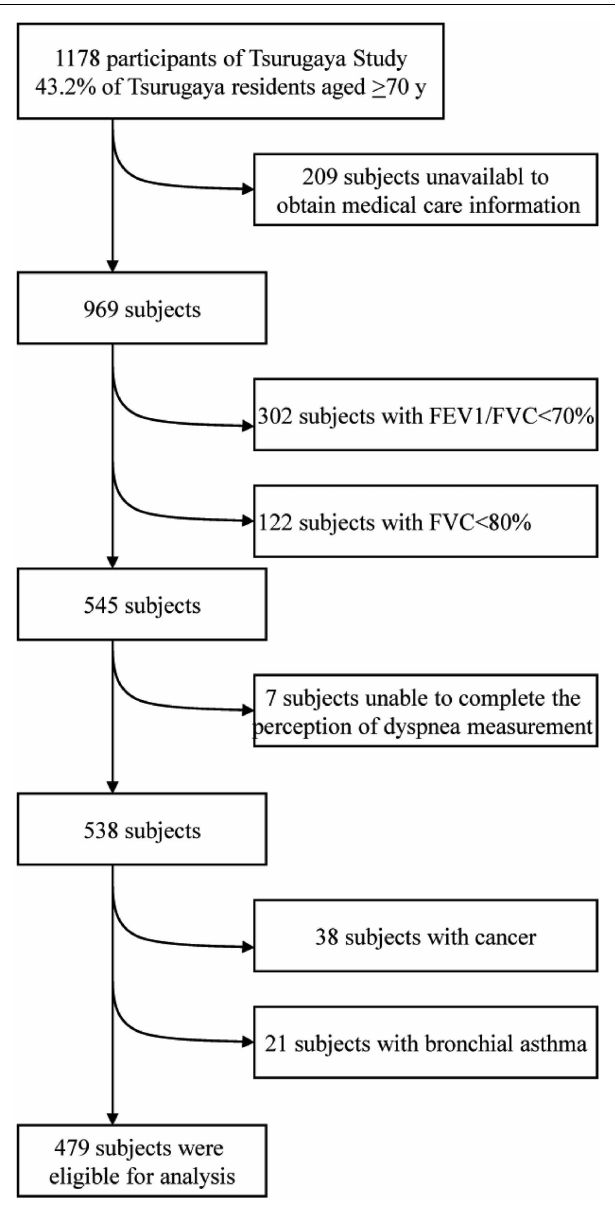
FIGURE 1 | Exclusion procedure. FEV1 denotes forced expiratory volume in 1s, FVC forced vital